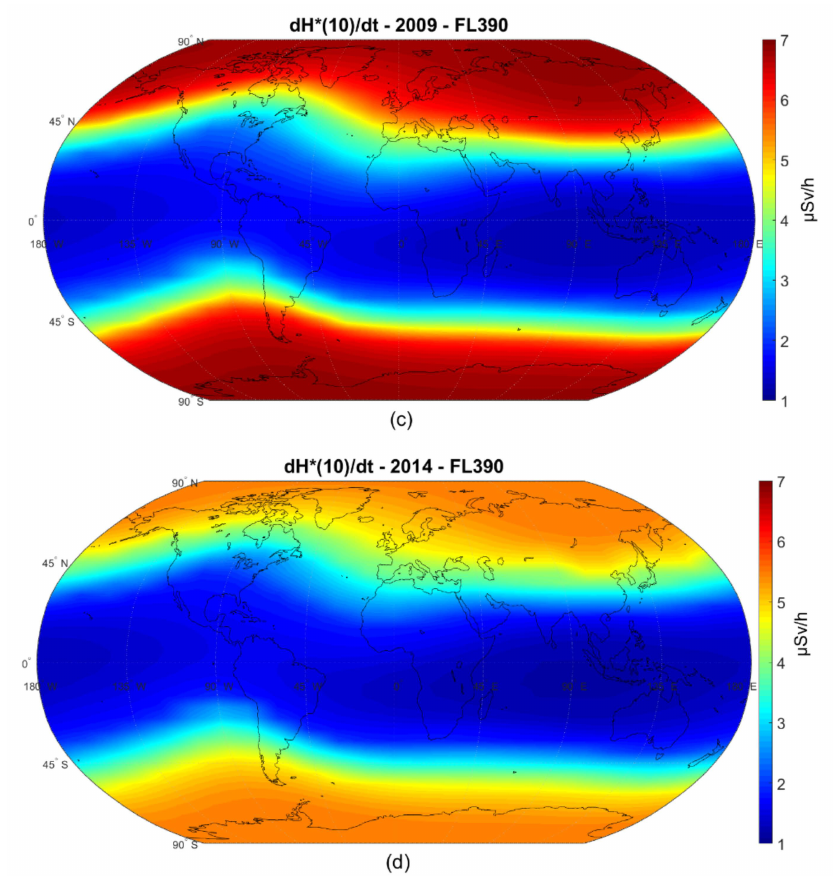
Figure 2. Maps of the estimated ambient dose equivalent rate ( µ Sv/h) at FL390: ( a ) during the minimum of solar cycle 23; ( b ) during the maximum of solar cycle 23; ( c ) during the minimum of solar cycle 24; ( d ) during the maximum of solar cycle